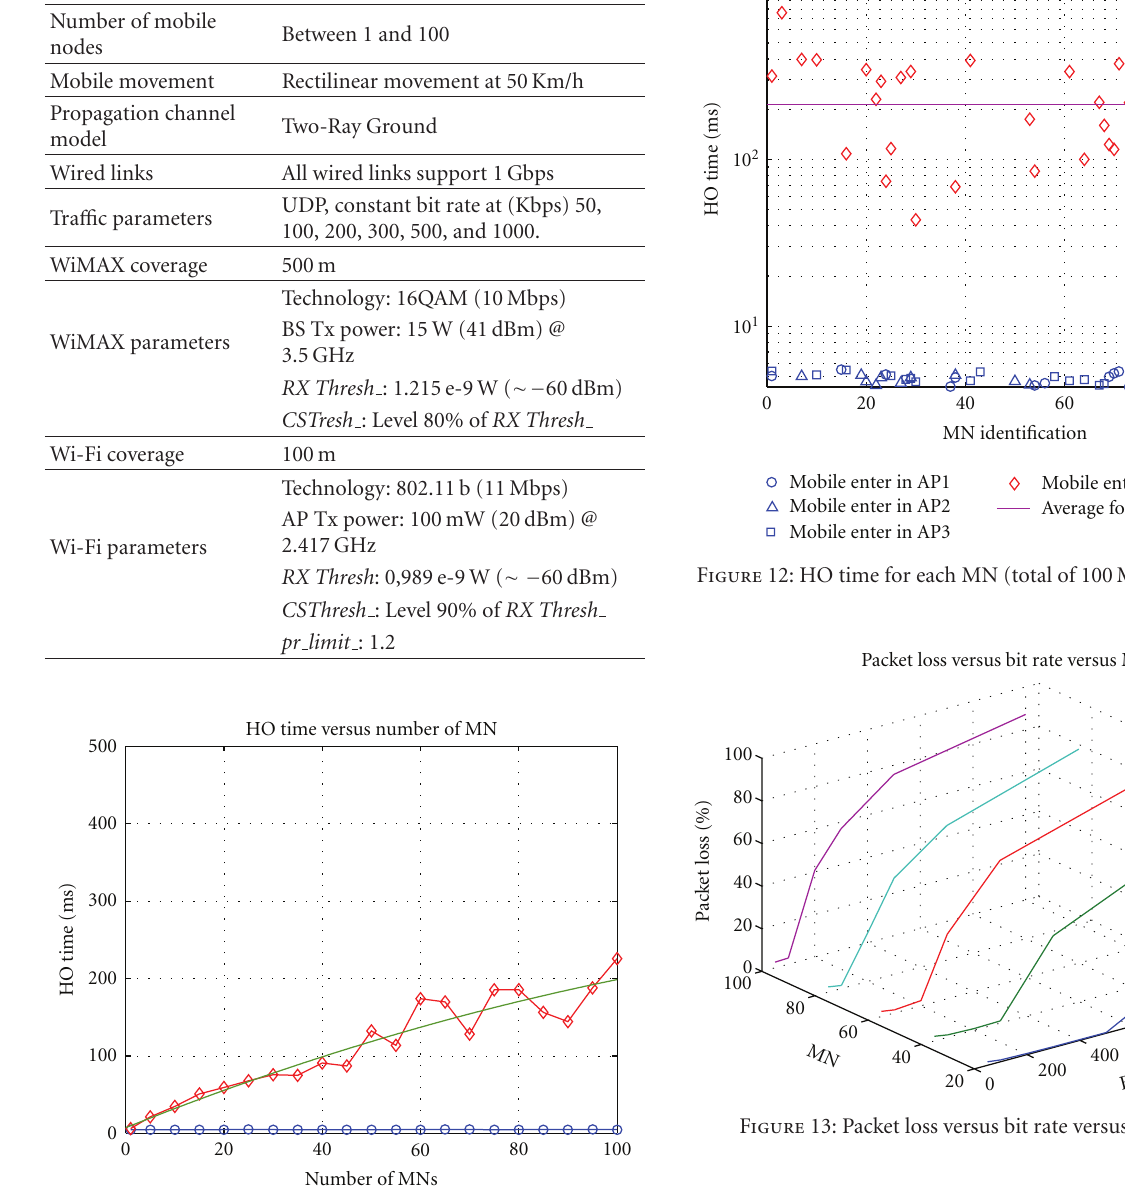
Table 3: Simulation parameters.